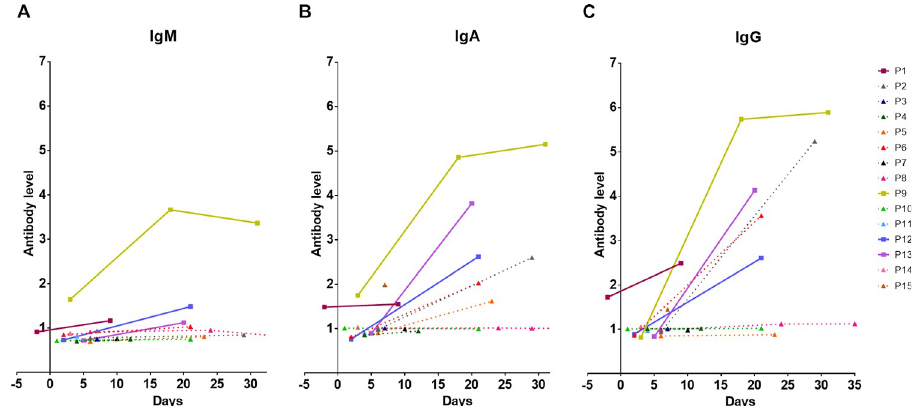
Fig 1. Longitudinal analysis of classes of antibody responses to RBD in COVID-19 patients. Dynamic changes in RBD-specific IgM (A), IgA (B) and IgG (C) antibody response in individual COVID-19 patients (N = 15). Data are plotted by antibody response calculated as the ratio between OD of uncoated and coated antigen well of an individual sample. Each line represents an individual subject. Solid line and square symbol represent pneumonia cases. Dot line and triangle symbol represent mild